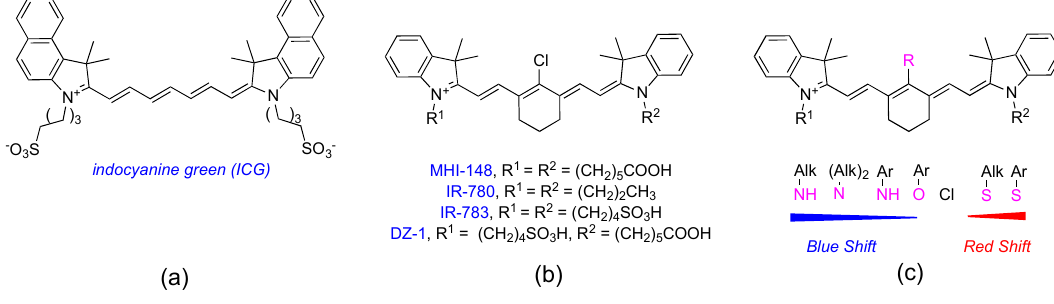
Figure 1. Structures of: ( a ) ICG; ( b ) cancer-tissue-targeting Cy-7 dyes and their meso -substituted derivatives; and ( c ) graphical representation of the effects of meso -substitution on electronic spectra.